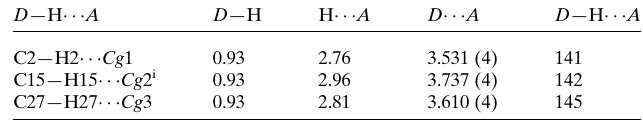
Table 1 Hydrogen-bond geometry (A˚ , (cid:2) ).